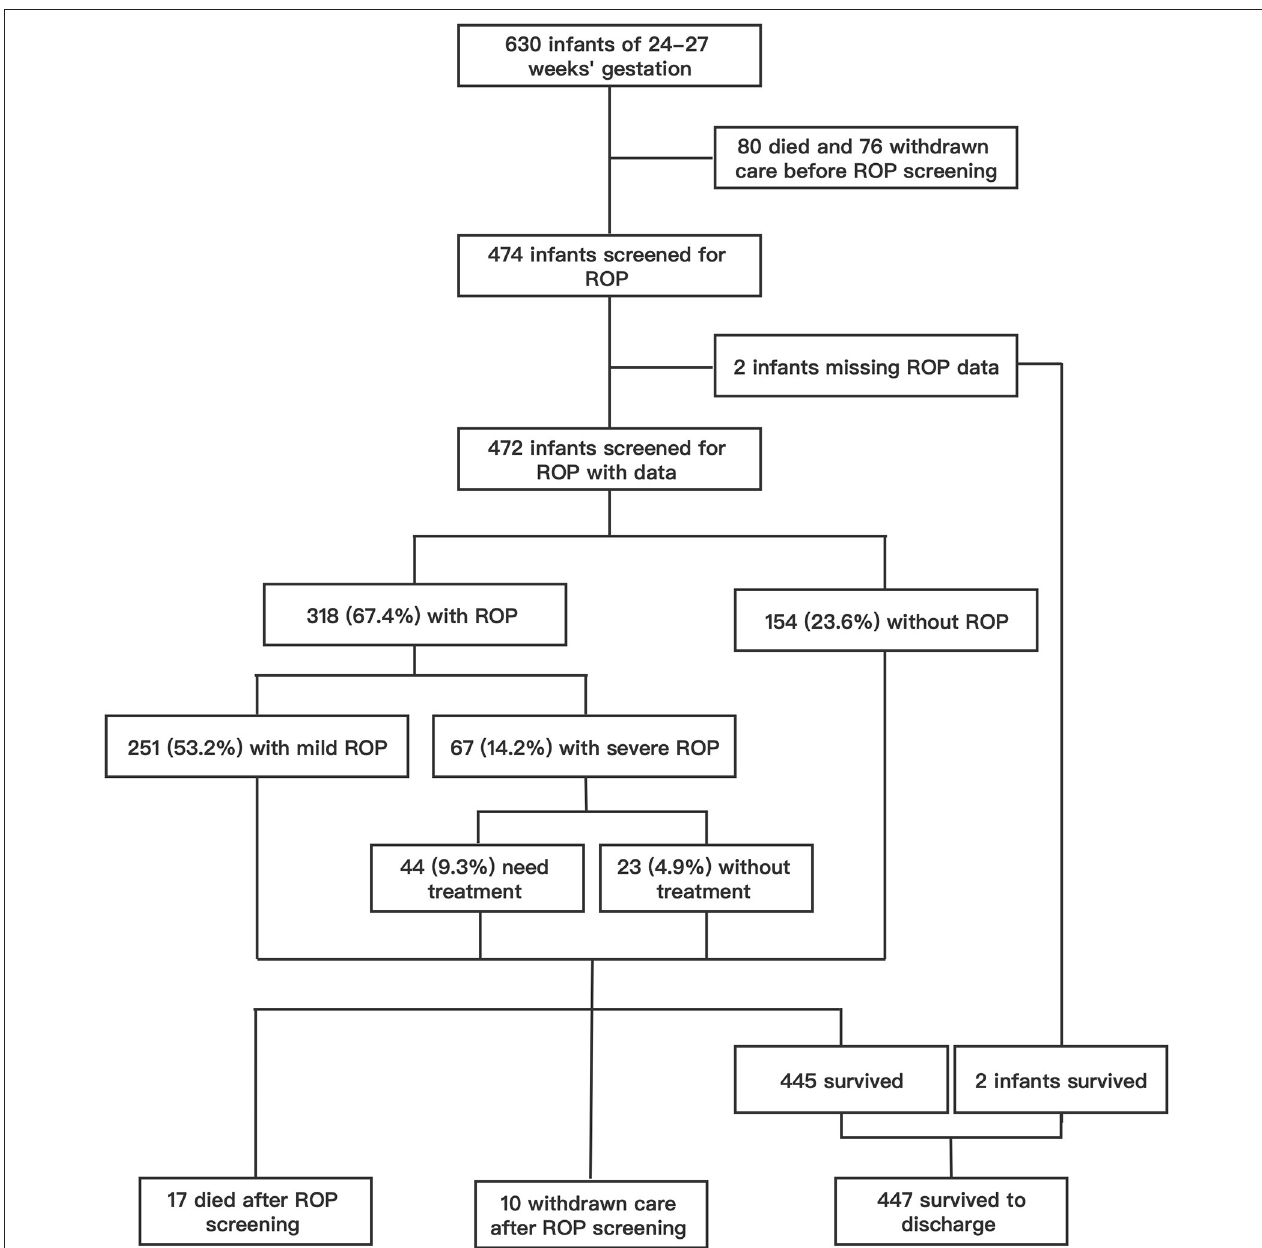
FIGURE 1 | The flow chart of study infants and the incidence of ROP in patients who screened for ROP.